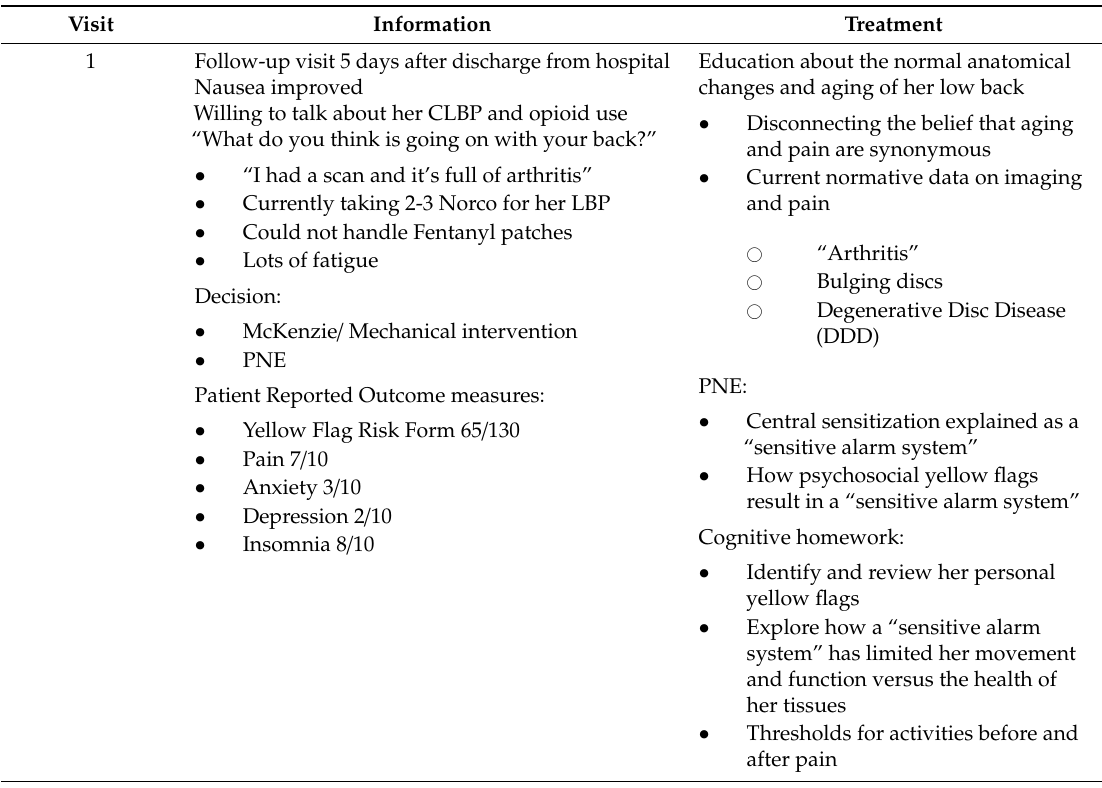
Table 2. Evaluation findings and interventions